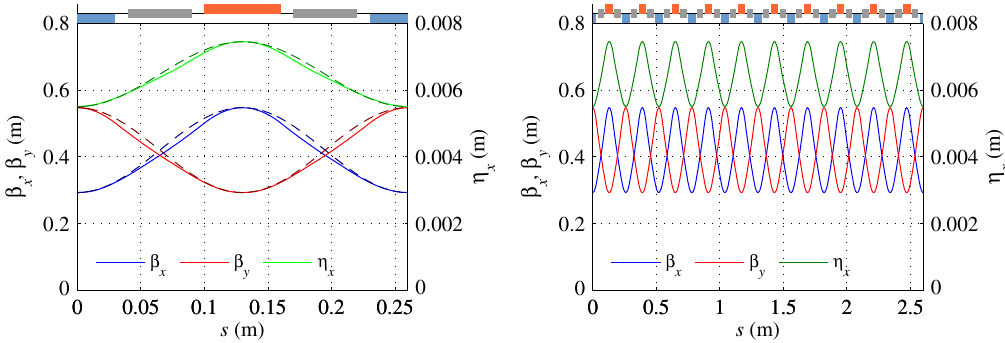
FIG. 1. The left figure shows a single cell of complex bend, and Twiss functions therein. The solid lines represent computer simulations; the dashed lines represent the approximate analytical solutions (3). The cell consists of two quadrupoles separated by short dipoles. The right figure shows an assembly of ten cells representing a complete complex bend